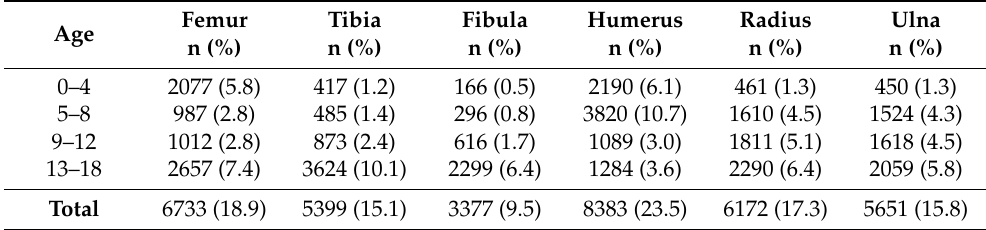
Table 2. Nonphyseal fractures for females according to age and long bone. N = 19,009.